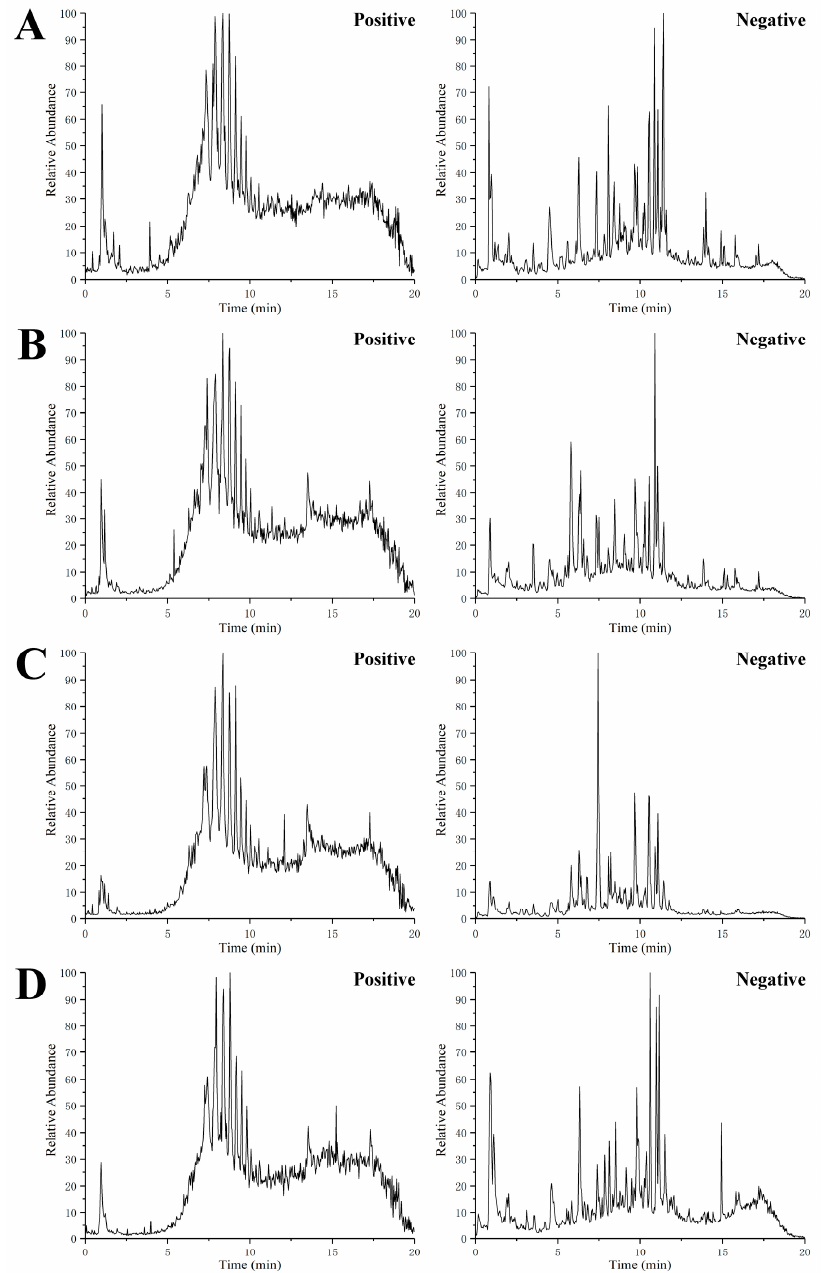
Figure 4. Representative UHPLC-MS total ion chromatograms (TIC) of urine from the control group ( A ), T2DM group ( B ), metformin group ( C ), and ginsenoside Re ( D ) group, respectively.